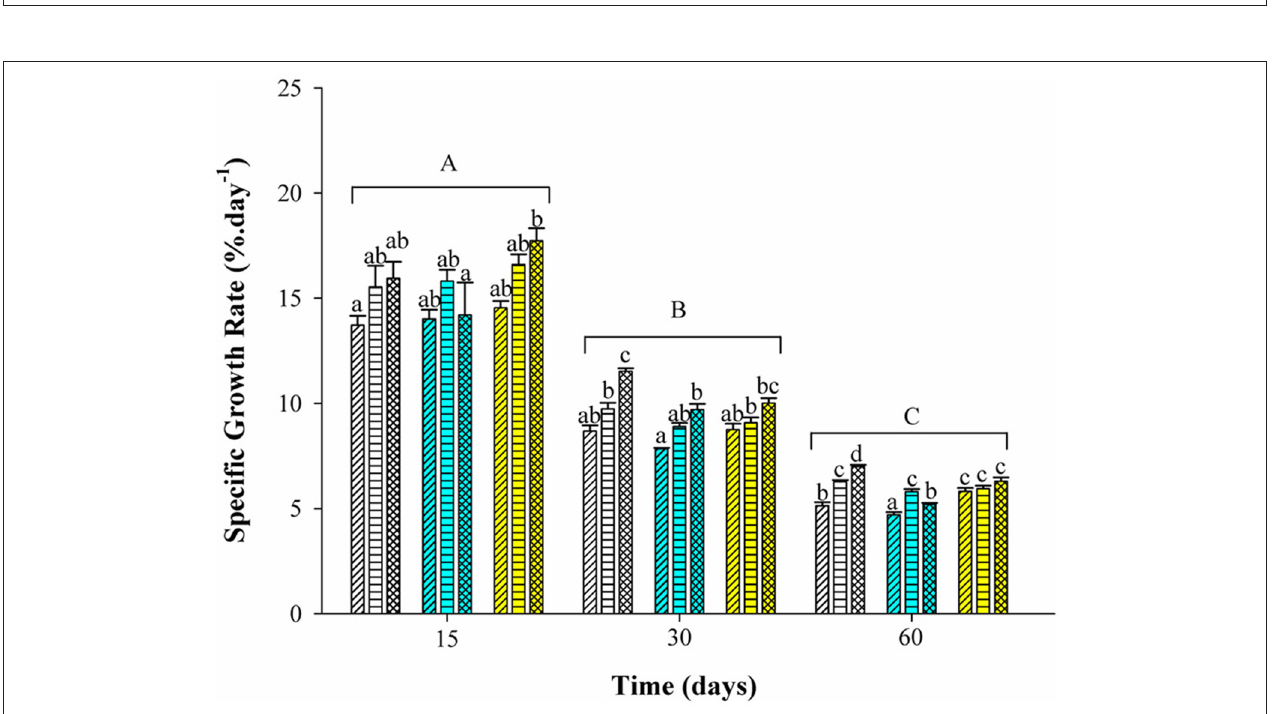
FIGURE 2 | Specific growth rate (%.day − 1 ) of juveniles of Colossoma macropomum under controlled conditions of photoperiod and temperature. Data are expressed as mean ± SEM ( n = 3). Different lowercase letters indicate significant differences in the different treatments at the same experimental period ( p < 0.05). The horizontal lines on the bars represent differences in experimental periods ( p < 0.05).